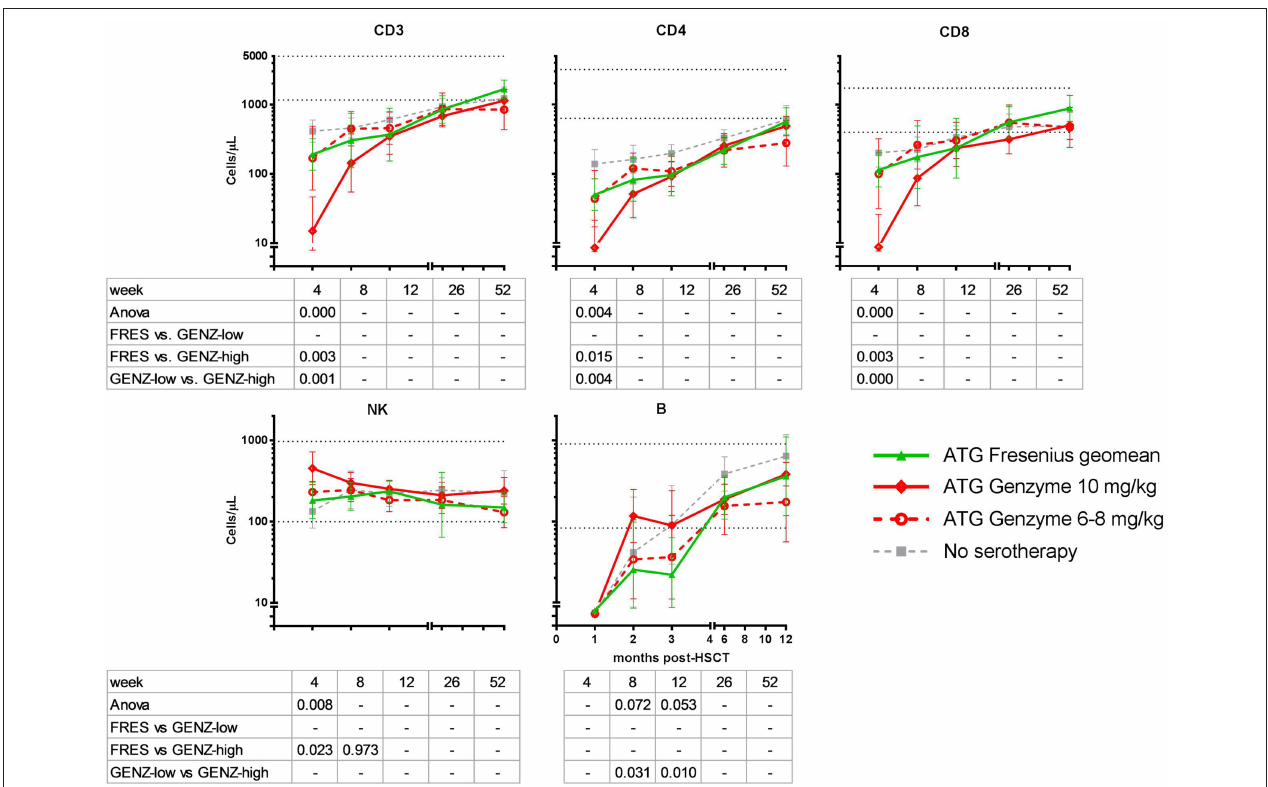
FIGURE 4 | Immune cell recovery post-HSCT in ATG-FRES (Fresenius) treated patients in comparison with high (ATG-GENZ-high) and low dose (ATG-GENZ-low) ATG-GENZ (Genzyme) treated patients. CD3 T-cell and CD4 and CD8 T-cell subset numbers differed significantly at one month post-HSCT between the two ATG treated groups. ATG-GENZ-high patients recovered significantly slower for CD3, CD4, and CD8 compared to the ATG-FRES and ATG-GENZ-low treated patients. In contrast to the T-cell recovery, NK-cells recovered fast after HSCT reaching normal levels within 1 month. The highest level of NK-cell numbers were observed at one month in the ATG-GENZ-high group. B-cell recovery in all ATG groups returned to normal levels at 6 months post-HSCT with a significantly higher number of B-cells at 2 and 3 months in the ATG-GENZ-high compared to the ATG-GENZ-low and ATG-FRES treated patients, respectively. Dotted horizontal lines represent the 5th and